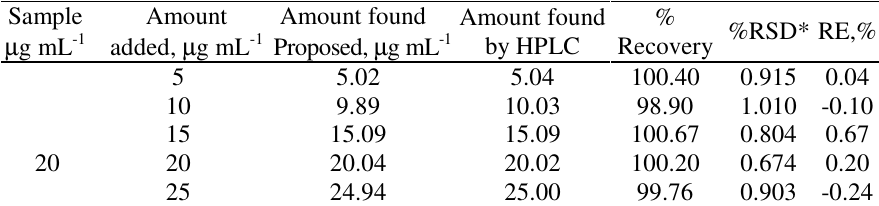
Table 3. Accuracy of the